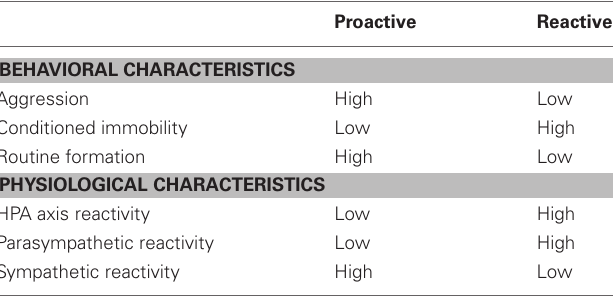
Table 1 | Summary of the behavioral and physiological differences between proactive and reactive